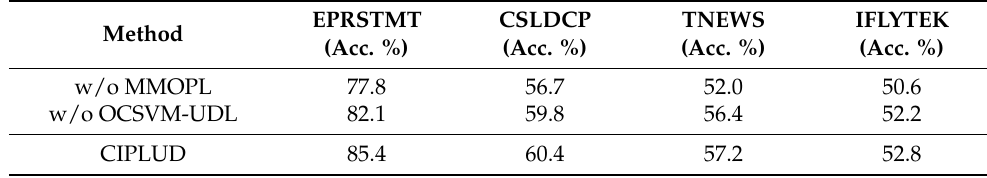
Table 5. The comparison results between our proposed method with or without MMOPL and